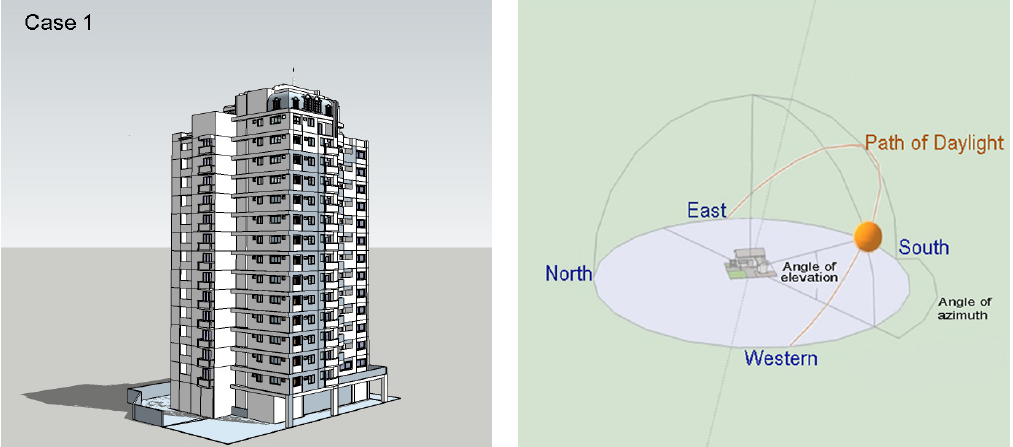
Figure 5. Traditional residential building planning designs for Case 1.